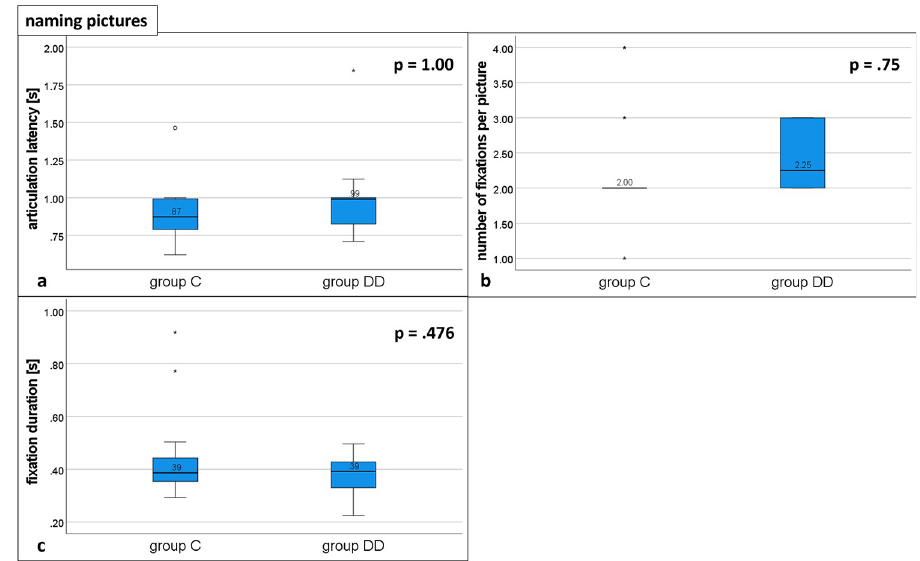
Fig 4. Eye movement variables during naming pictures. Distribution of group DD and group C: Medians for a) articulation latency, b) number of fixations, and c) fixation duration; p = probability value. There was no statistically significant difference between the groups for all 3 eye movement variables. See Table 2 for details.